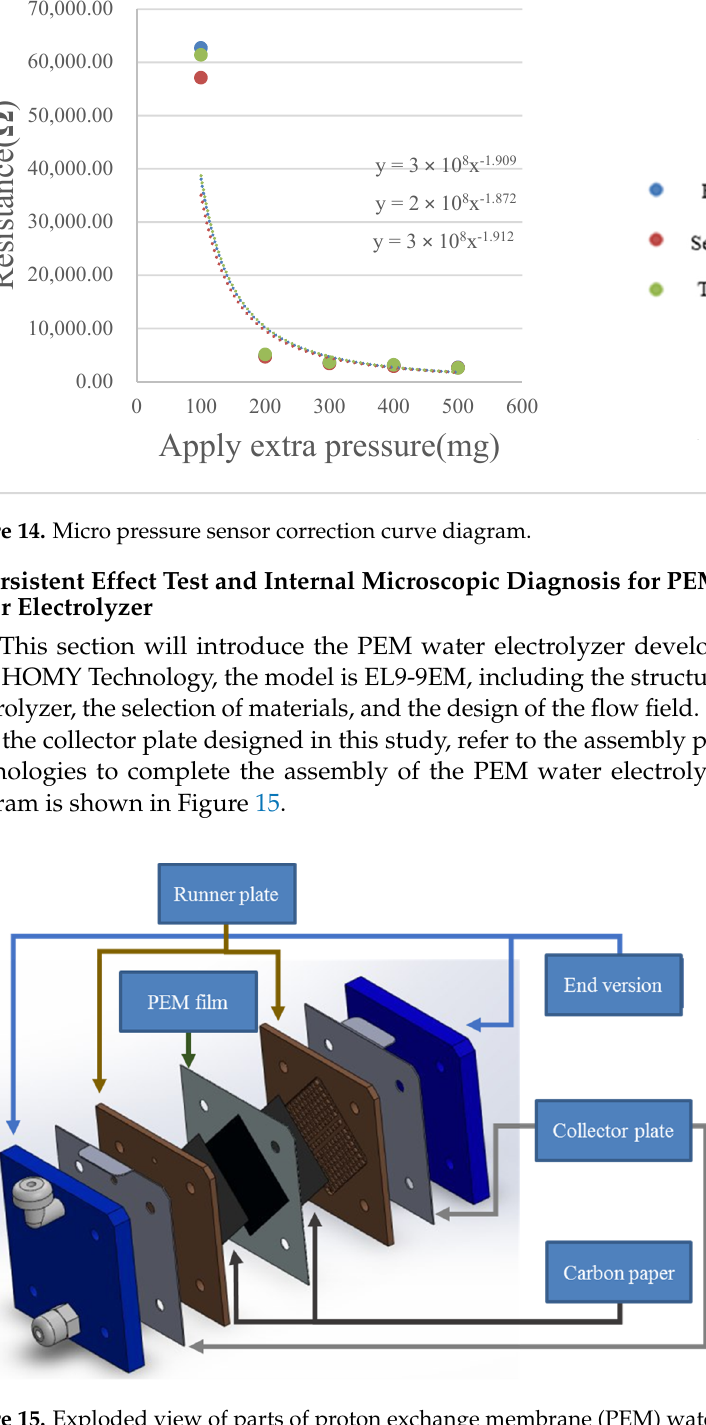
Figure 15. Exploded view of parts of proton exchange membrane (PEM) water electrolyzer.